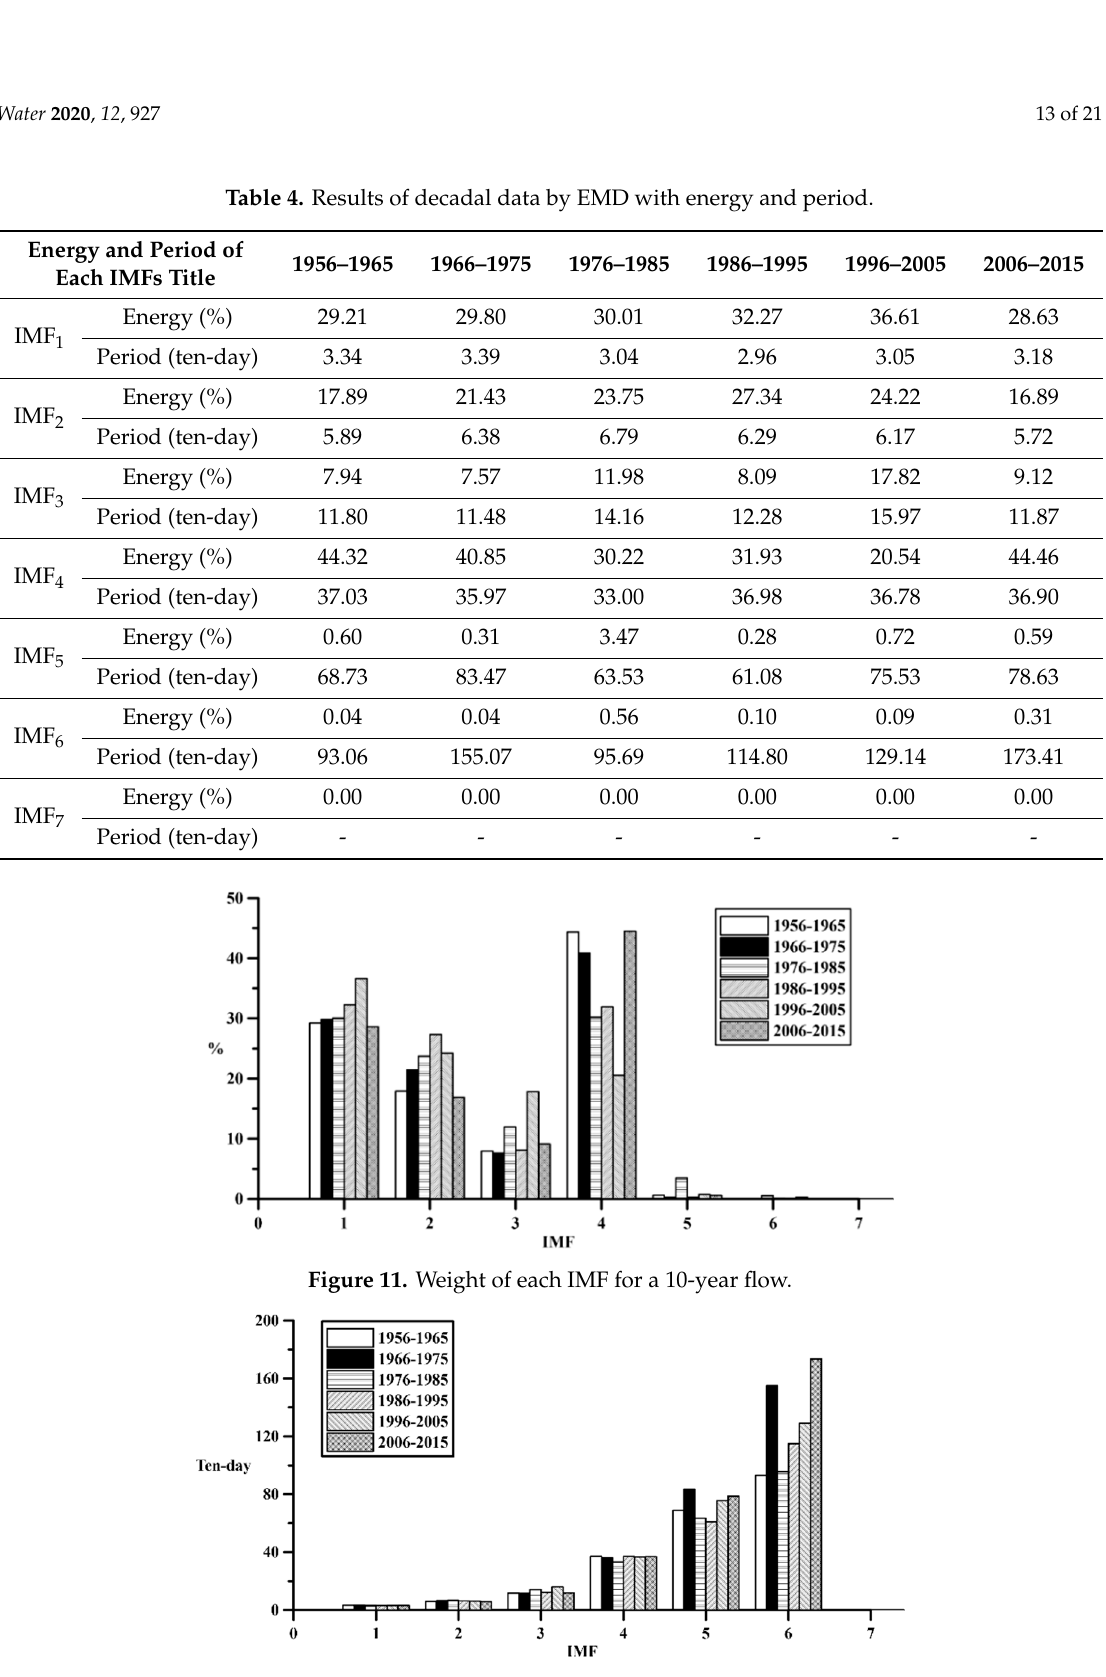
Table 4. Results of decadal data by EMD with energy and period.